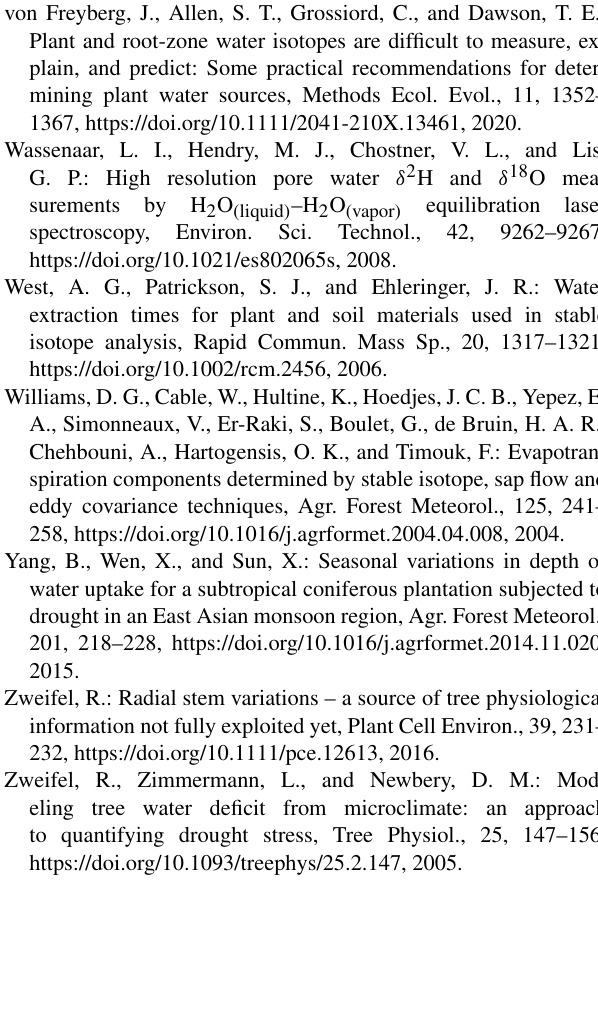
STG (German Stratigraphic Commission): Stratigraphic Table of Germany 2016, – Potsdam (German Research Centre for Geo- sciences), (1) Table plain 100 × 141 cm, (2) Table folded